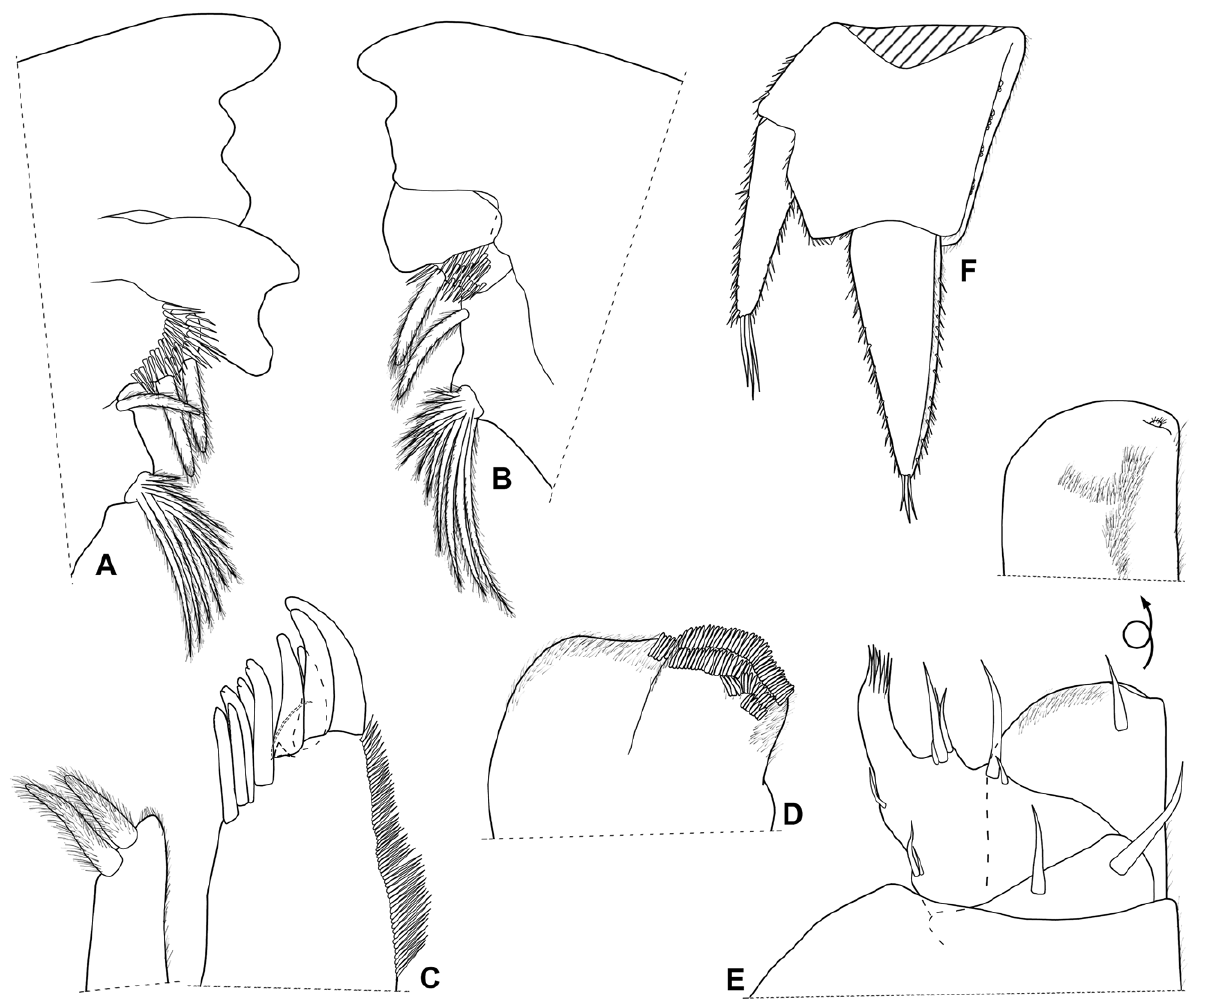
Figure 2. Alloniscus buckupi Campos-Filho & Cardoso n. sp., paratype. A, left mandible; B, right mandible; C, maxillula; D, maxila; E, maxilliped; F,